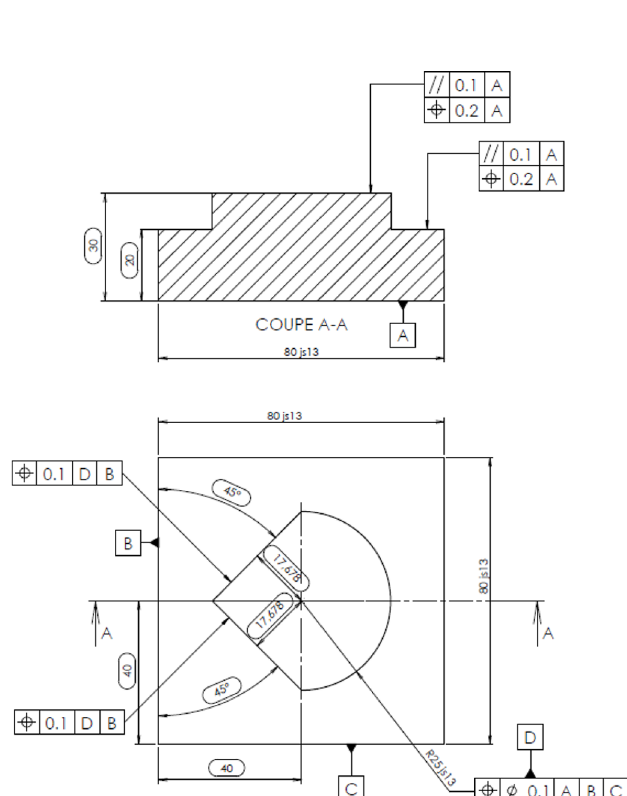
Fig. 1. Systems of coordinate.